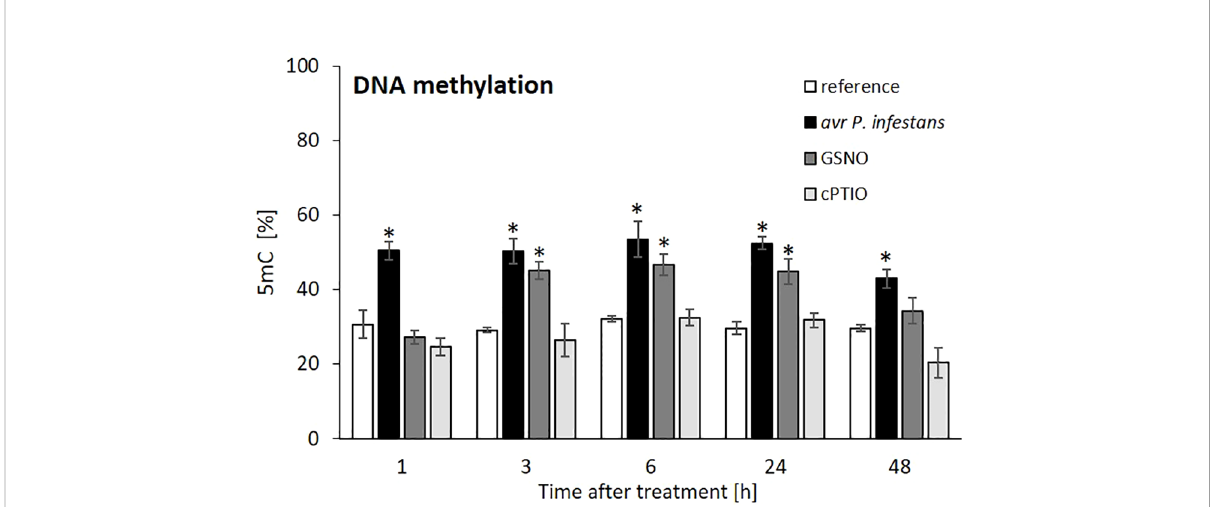
FIGURE 2 Effect of avr P. infestans or GSNO on global DNA methylation in potato leaves of cv. Sarpo Mira. The ELISA test of 5-mC DNA level was performed at selected time points at 1-48 h after GSNO, cPTIO treatment, or challenge inoculation. There were no signi fi cant changes in the absolute values of the analyzed 5-mC levels after the leaves spraying with water.Values represent the means of data ± SD of at least three independent experiments. Asterisks indicate values that differ signi fi cantly from water-treated (reference) potato leaves at a <0.05 ( ∗ ).